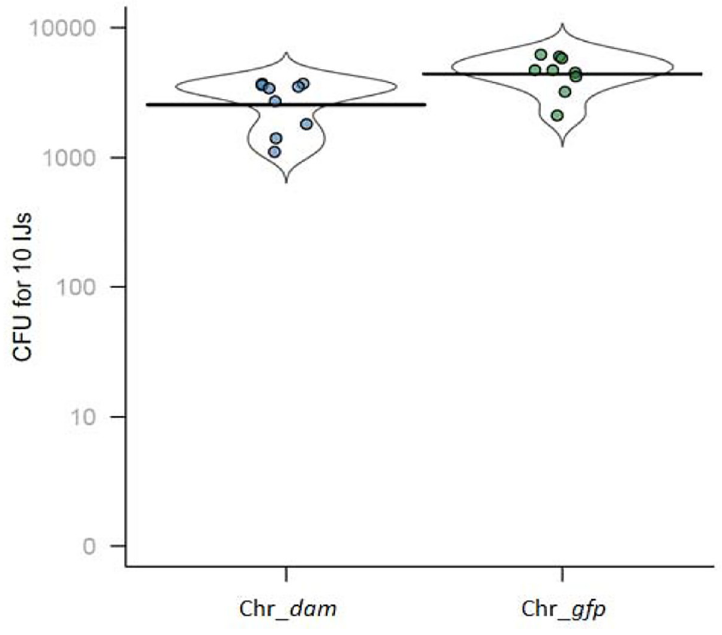
Fig 4. CFU in IJs nematodes for each strain. After crushing of 10 IJs and plating of the resulting suspension, CFU were numerated. A significant difference was observed between the two strains (glmm, p-value <